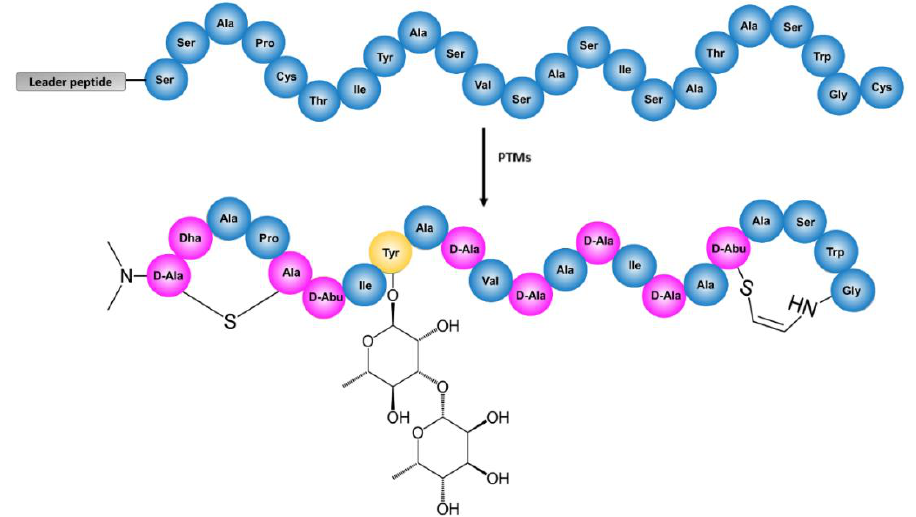
Figure 1. Structure of cacaoidin before (top) and after (bottom) the Post-Translational Modifications (PTMs). In the modified cacaoidin, absolute configuration for NMe2Ala(S)-1 is tentatively proposed as (2S) (equivalently, D -Ala). The amino acids modified by biosynthetic enzymes are colored in pink, the glycosylated tyrosine is colored in yellow, and the non-modified amino acids are colored in blue.